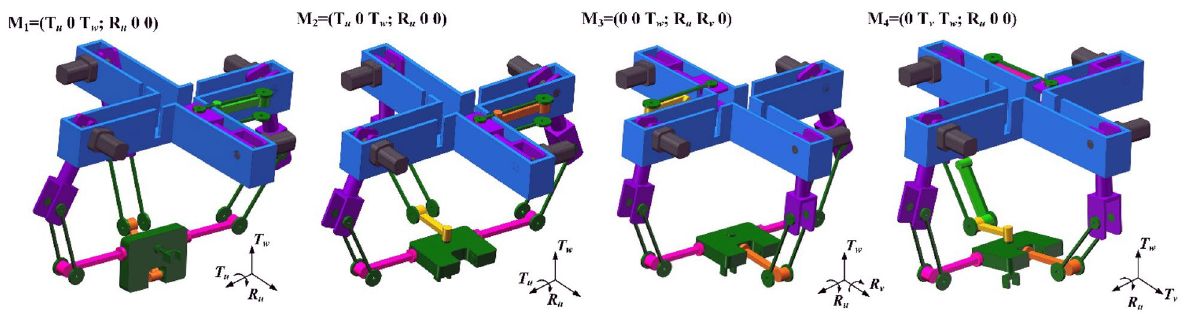
Figure 14 Design procedure of multiarm robot mechanism